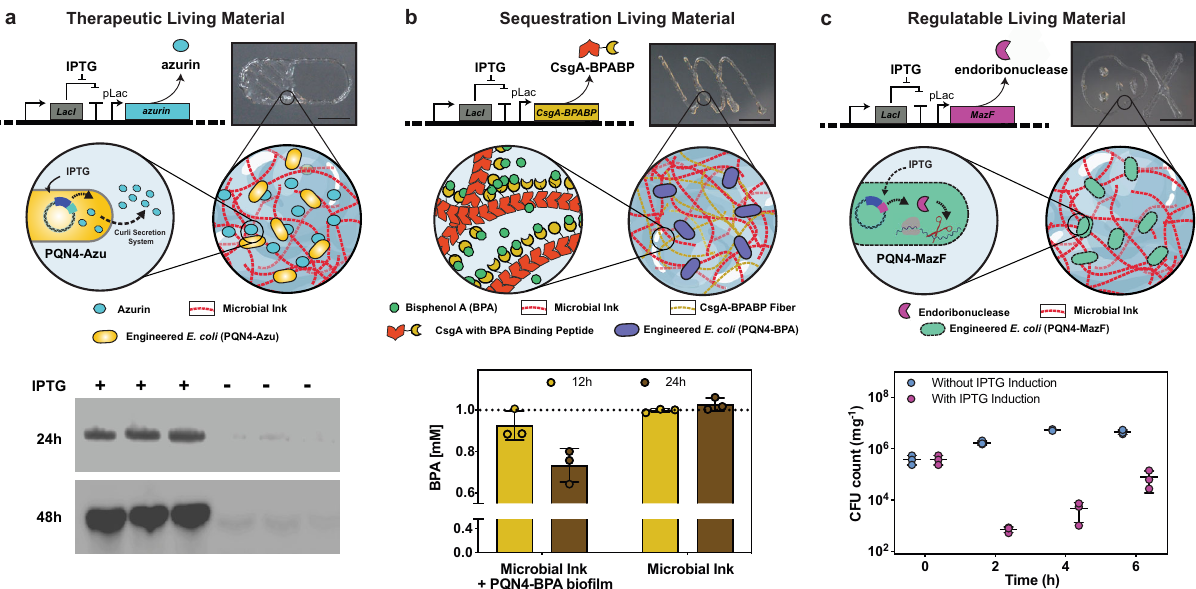
Fig. 4 3D printing of functional living materials. a Genetic design of E. coli (PQN4-Azu) cells, programmed to secrete an anticancer biologic drug azurin along with image of printed living material (top), and the incorporation of PQN4-Azu cells into the CsgA- αγ microbial ink (middle). Western blot (bottom) shows the difference in azurin detected in the supernatant of the printed structure with and without IPTG induction. b Genetic design of E. coli (PQN4- BPA), programmed to produce extracellular fi bers displaying BPA-binding peptide (CsgA-BPABP) along with image of printed living material (top), and incorporation of CsgA-BPABP bio fi lm into microbial ink (middle). After 12 and 24 h, the BPA concentration (bottom) in the supernatant of the printed structure was analyzed by LCMS. Dotted line represents the initial BPA concentration of 1 mM. n = 3. c Genetic design of E. coli (PQN4-MazF) cells, programmed to express an endoribonuclease MazF, that inhibits/arrests cell growth along with image of printed living material (top), and incorporation of PQN4-MazF cells into microbial ink (middle). CFU count from printed structure over time, with and without IPTG induction (bottom). n = 3. Scale bar 5 mm. Data represented as mean ± standard